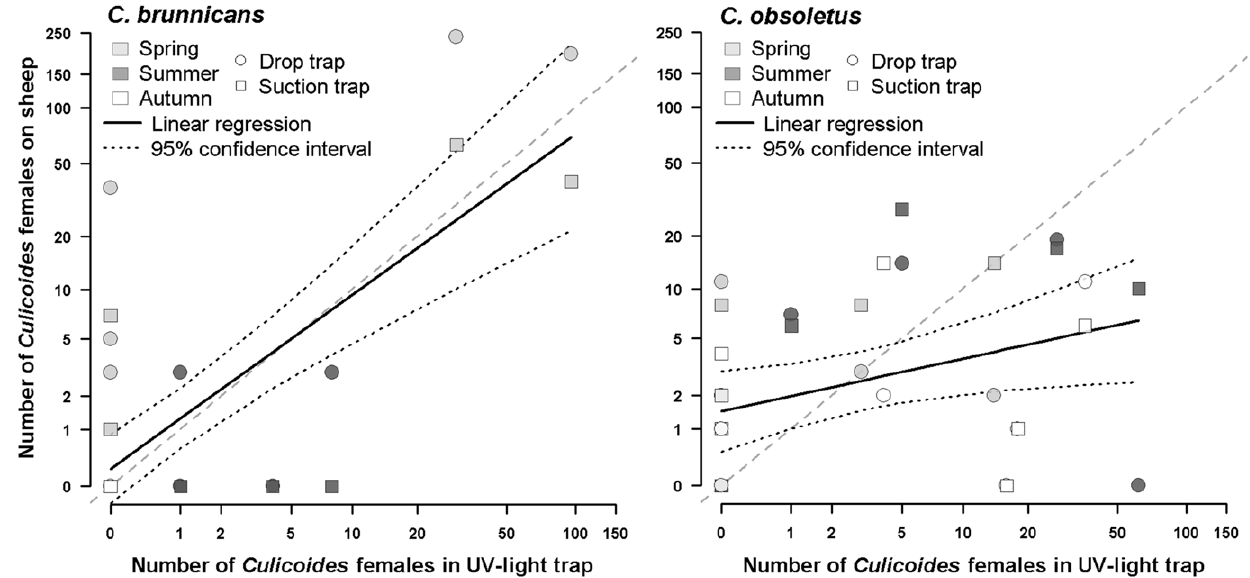
Figure 6. Inside and outside schemes and pictures of the suction trap.